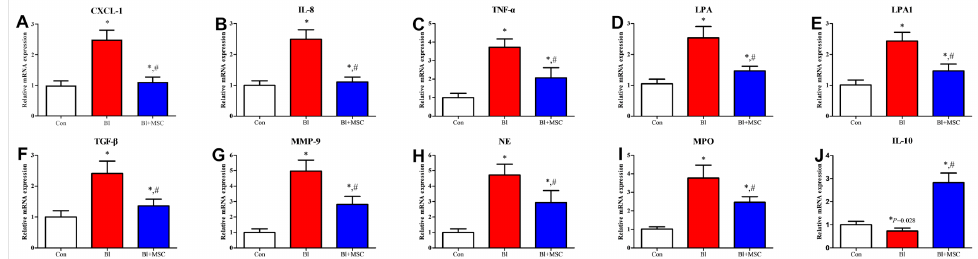
Figure 10. Effects of GMSCs on the gene expression levels of inflammatory and fibrotic factors. Assessment of the mRNA expression levels of the inflammatory factors CXCL-1 ( A ), IL-8 ( B ), TNF- α ( C ), LPA ( D ), LPA1 ( E ), TGF- β ( F ), MMP-9 ( G ) , NE ( H ) , MPO ( I ) and IL-10 ( J ) in lung tissue. * p < 0.05 indicates significant differences versus the Con group; # p < 0.05 indicates significant differences versus the Bl group. Values are expressed as the mean ± SEM. Abbreviations: IL, interleukin; TNF, tumour necrosis factor; CXCL, C-X-C motif chemokine ligand; TGF, transforming growth factor; LPA, lysophosphatidic acid; LPA1, lysophosphatidic acid receptor 1; MMP, matrix metalloproteinase; NE, neutrophil elastase; MPO, myeloperoxidase. White bars indicates Con group, red bars indicates Bl group, blue bars indicate Bl + MSC